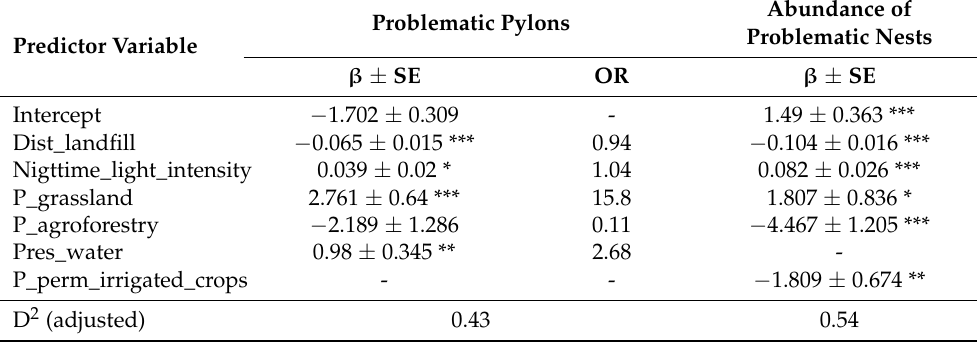
Table 2. Results of reduced binomial and negative binomial GLMs modeling the probability of transmission pylons being occupied by problematic white stork ( Ciconia ciconia ) nests and abundance of problematic nests, respectively, in the study area (southwestern Spain). Both models are based on individual towers with 1 km radius buffers ( n = 1196) plus a residual auto covariate RAC term with a 1 km spatial neighborhood size. Coefficient estimates ( β ) ± standard error (SE), and odds ratios (OR) are reported for reduced model with the lowest AIC score. Significant terms are highlighted: * p < 0.05, ** p < 0.01, *** p < 0.001. Abundance of Problematic Pylons Problematic Nests Predictor Variable β ± SE OR β ± SE Intercept − 1.702 ± 0.309 - 1.49 ± 0.363 *** Dist_landfill − 0.065 ± 0.015 *** 0.94 − 0.104 ± 0.016 *** Nigttime_light_intensity 0.039 ± 0.02